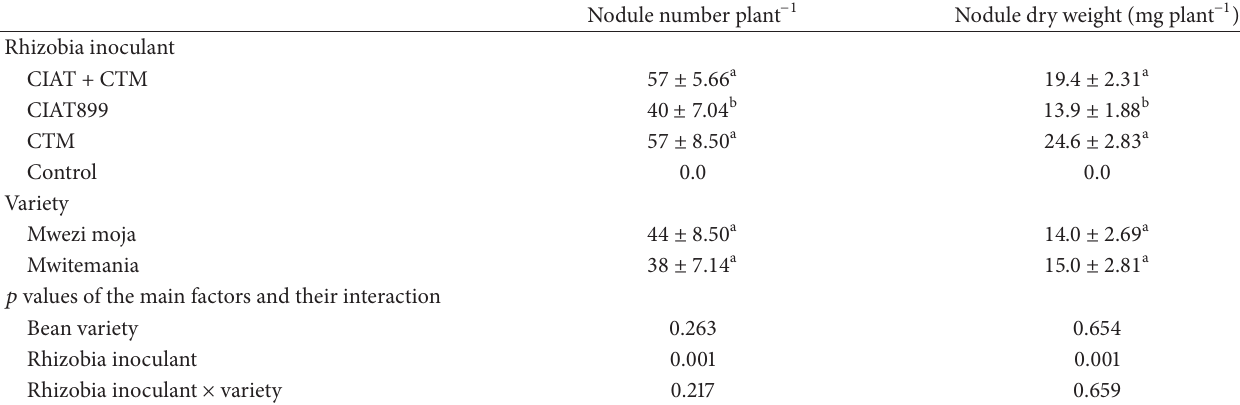
Table 1: Nodule number and nodule dry weight (mg plant −1 ) as affected by rhizobia inoculants and bean